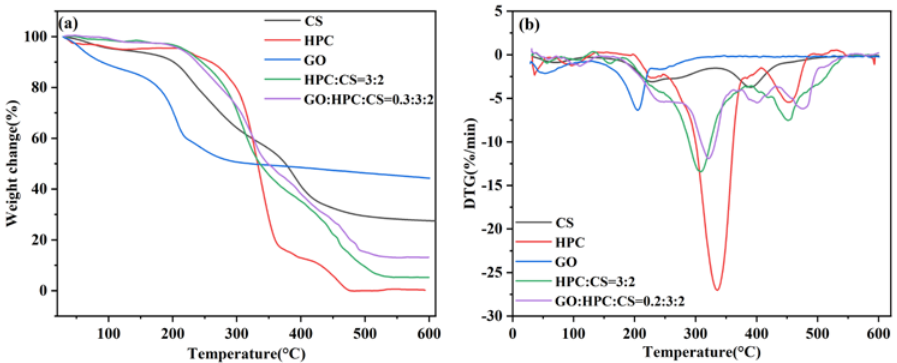
Figure 5. TG ( a ) and DTG ( b ) curves of CS, HPC, GO, and aerogels.